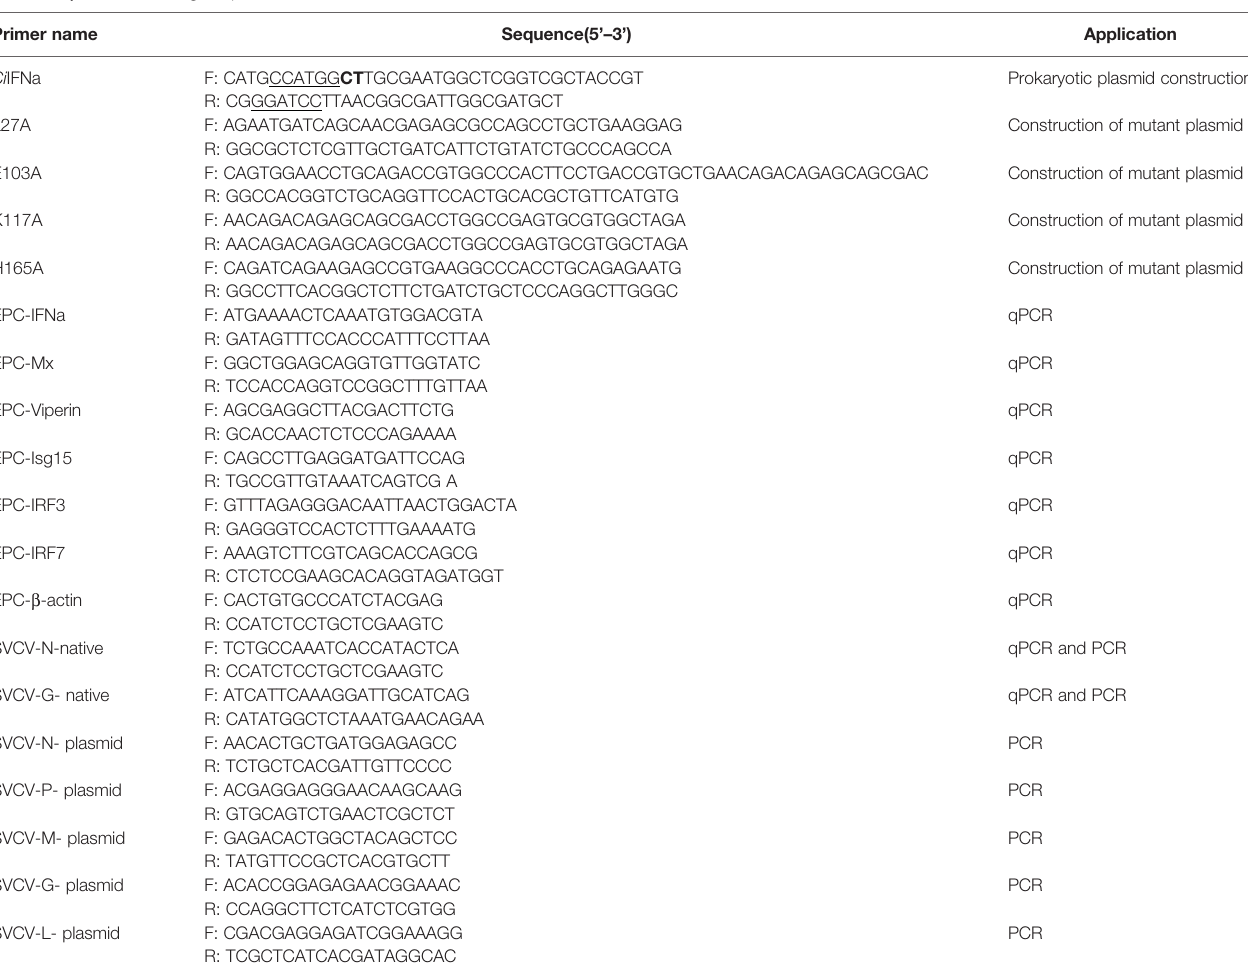
TABLE 1 | Information of gene